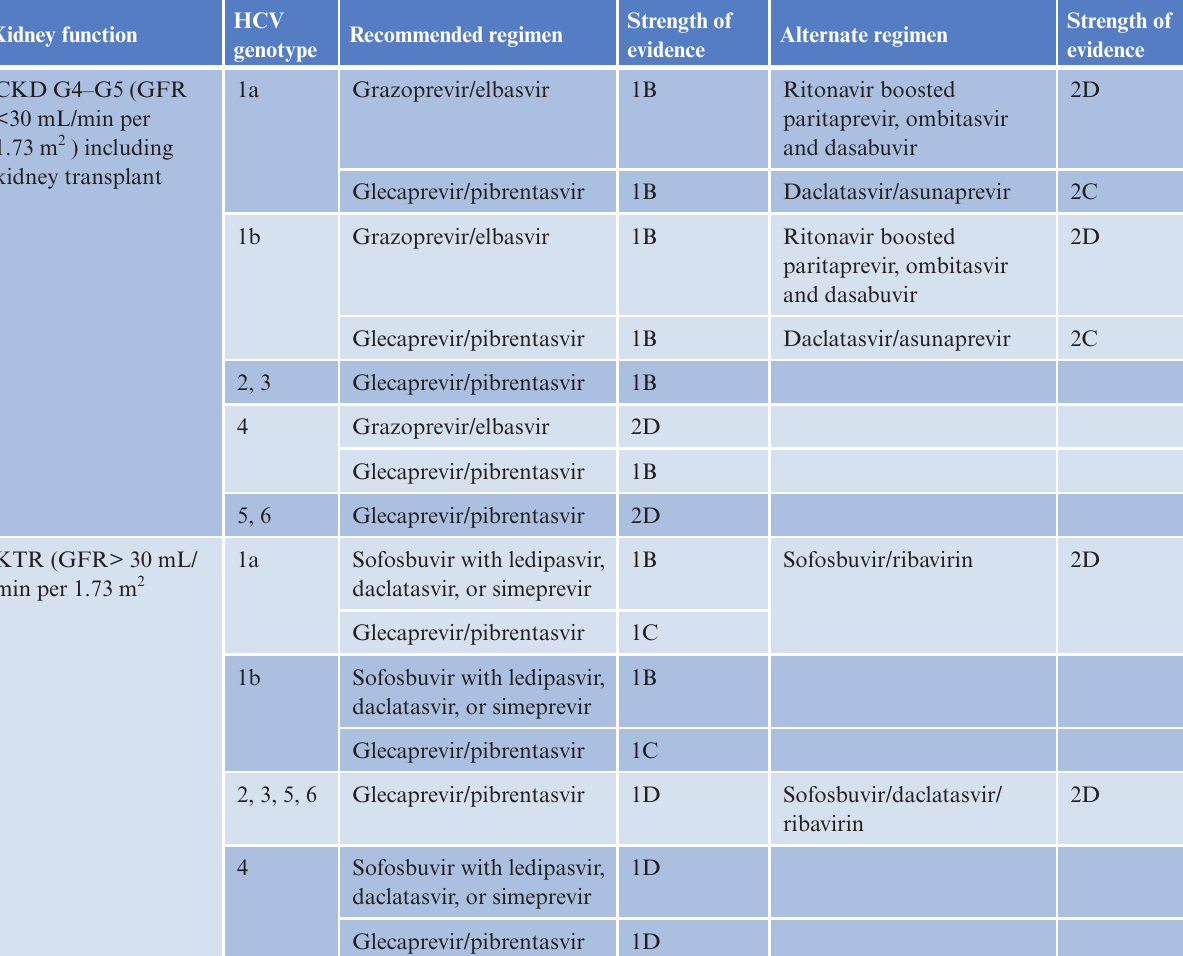
Table 5. Recommended direct-acting antiviral (DAA) treatment regimens for patients with chronic kidney disease G4-G5 and kidney transplant recipients by hepatitis C virus genotype (104) Kidney